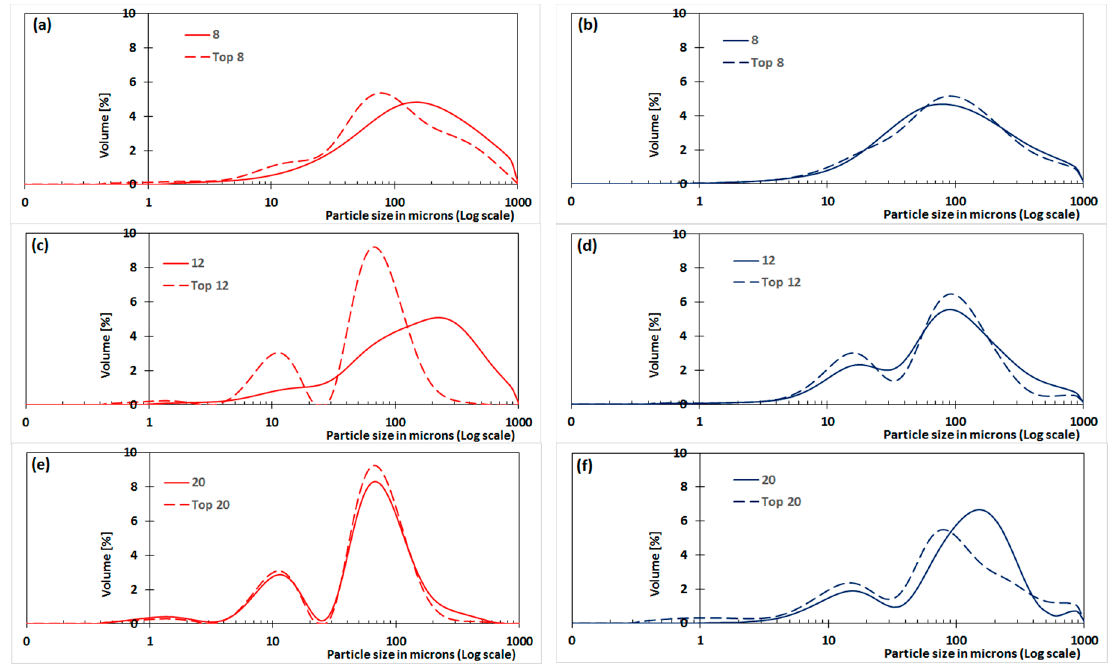
Figure 4. Comparison of PSD at the top and bottom of the pond for ( a , b ) resuspension areas; ( c , d ) sedimentation areas and ( e , f ) non-sedimentation